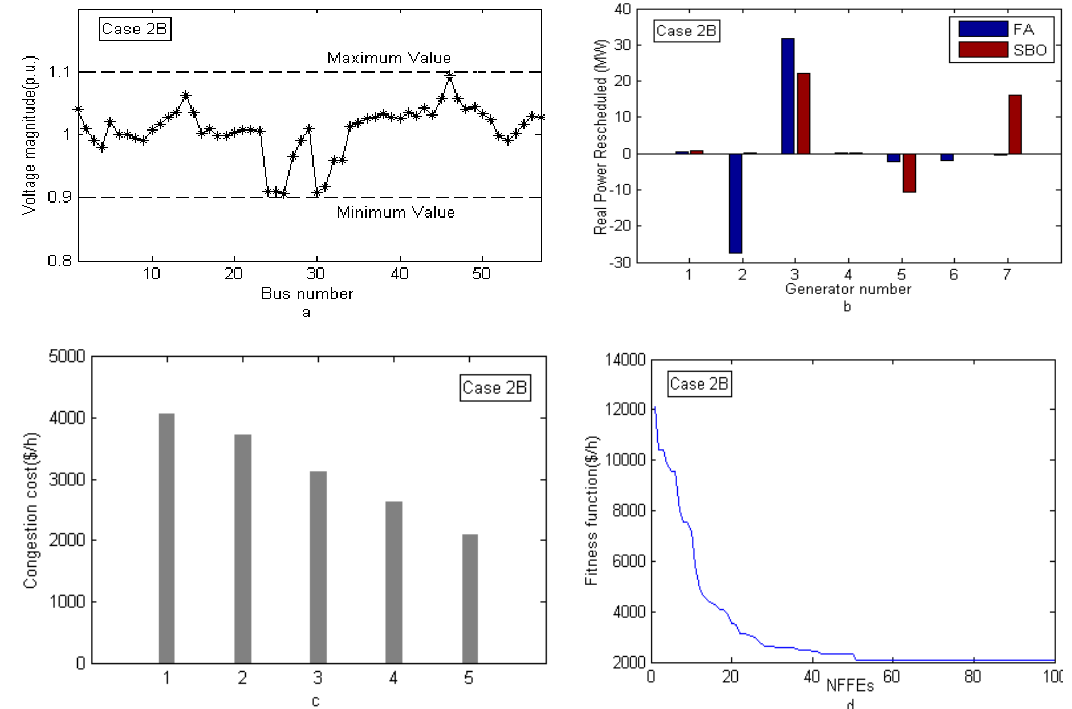
Figure 4. Simulation results for Case 2B. ( a ) voltage magnitude in p.u.; ( b ) change in real-power in MW; ( c ) congestion cost in $/h; ( d ) convergence profile.